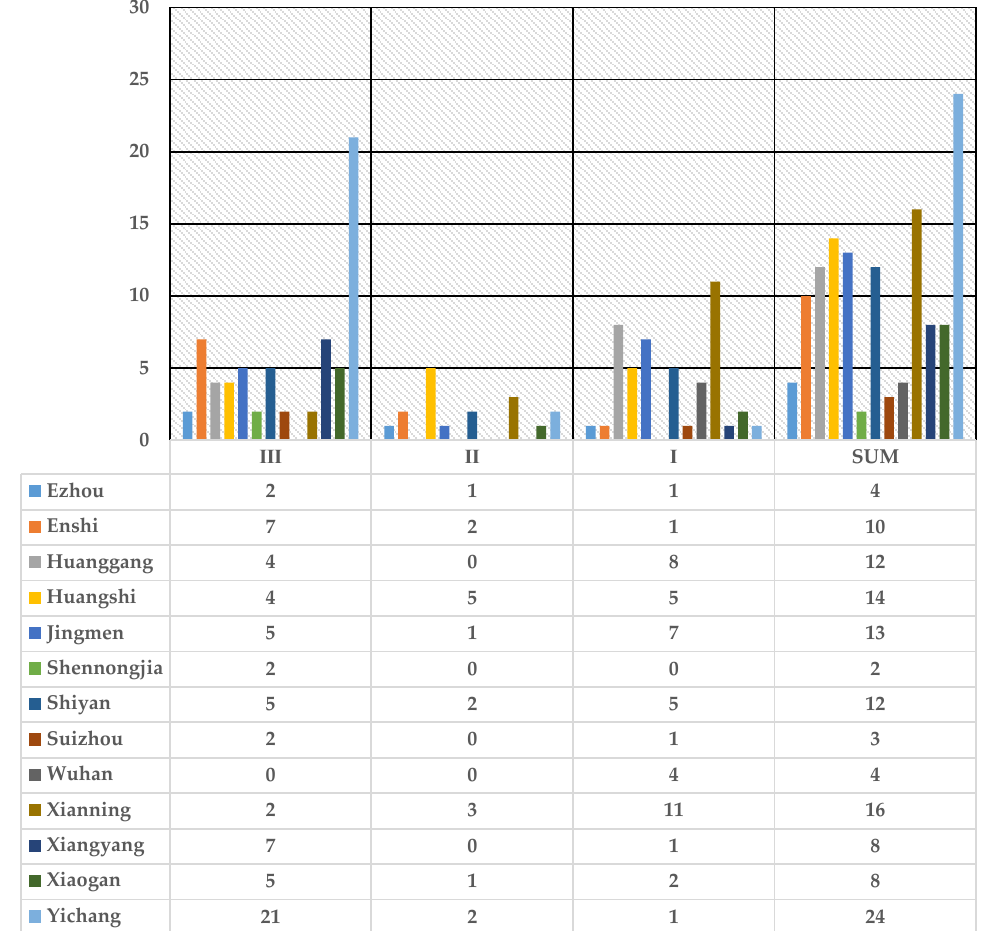
Table 4. The level of land occupation and destruction of cities in Hubei.